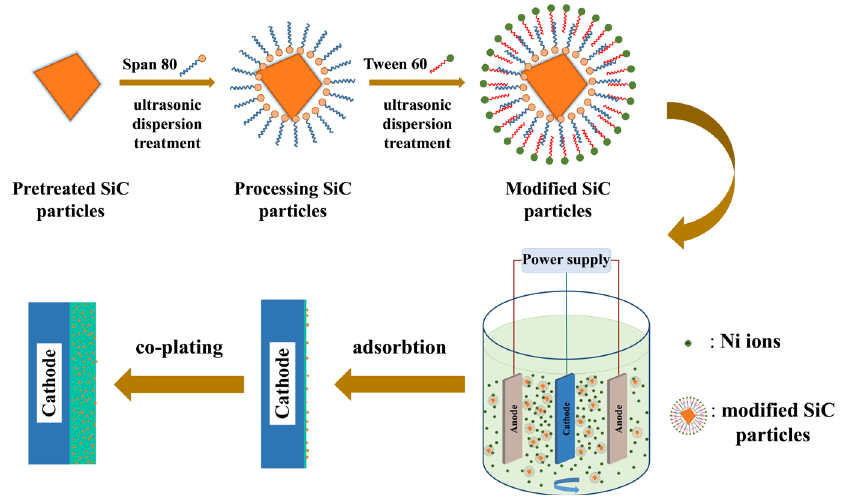
Figure 1. Schematic illustrating the modification of SiC particles and the co - plating of Ni/SiC coat- ings